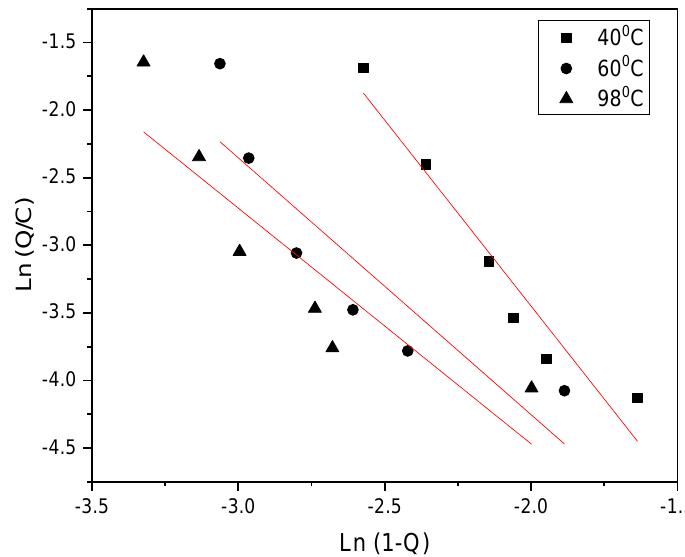
Figure 4. Graphic representation of a linear Florry-Huggins model for dyeing polyamide 6.6 fabric at different